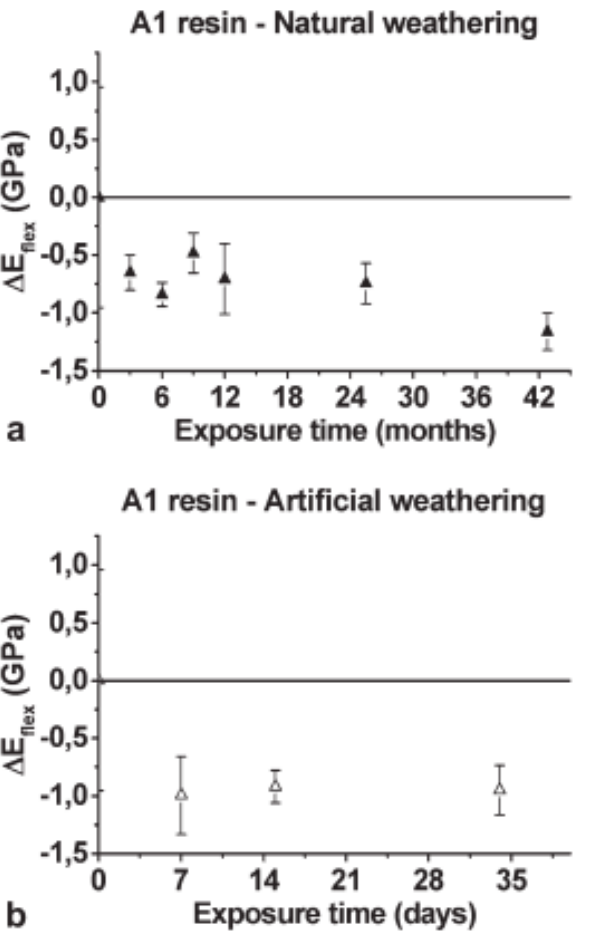
Figure 6. Variations in the flexural modulus of elasticity ( ∆ E flex ) measured on A1 resin relative to the initial value calculated for unexposed specimens measured during ( a ) natural weathering and ( b ) artificial aging. Reprinted with permission [52].